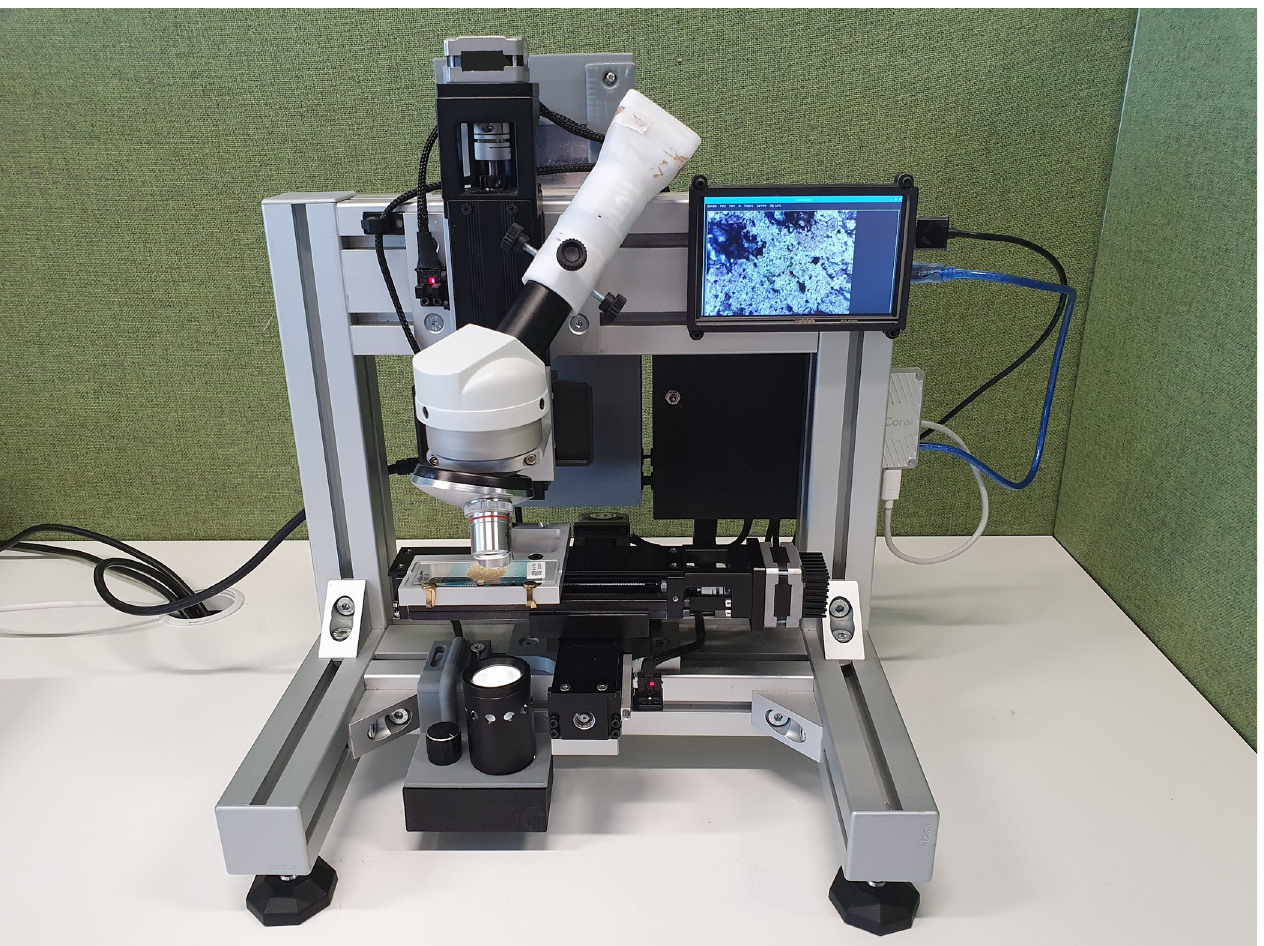
Fig 2. A prototype of a low-cost fieldable whole slide imaging device for Kato-Katz stool thick smears.